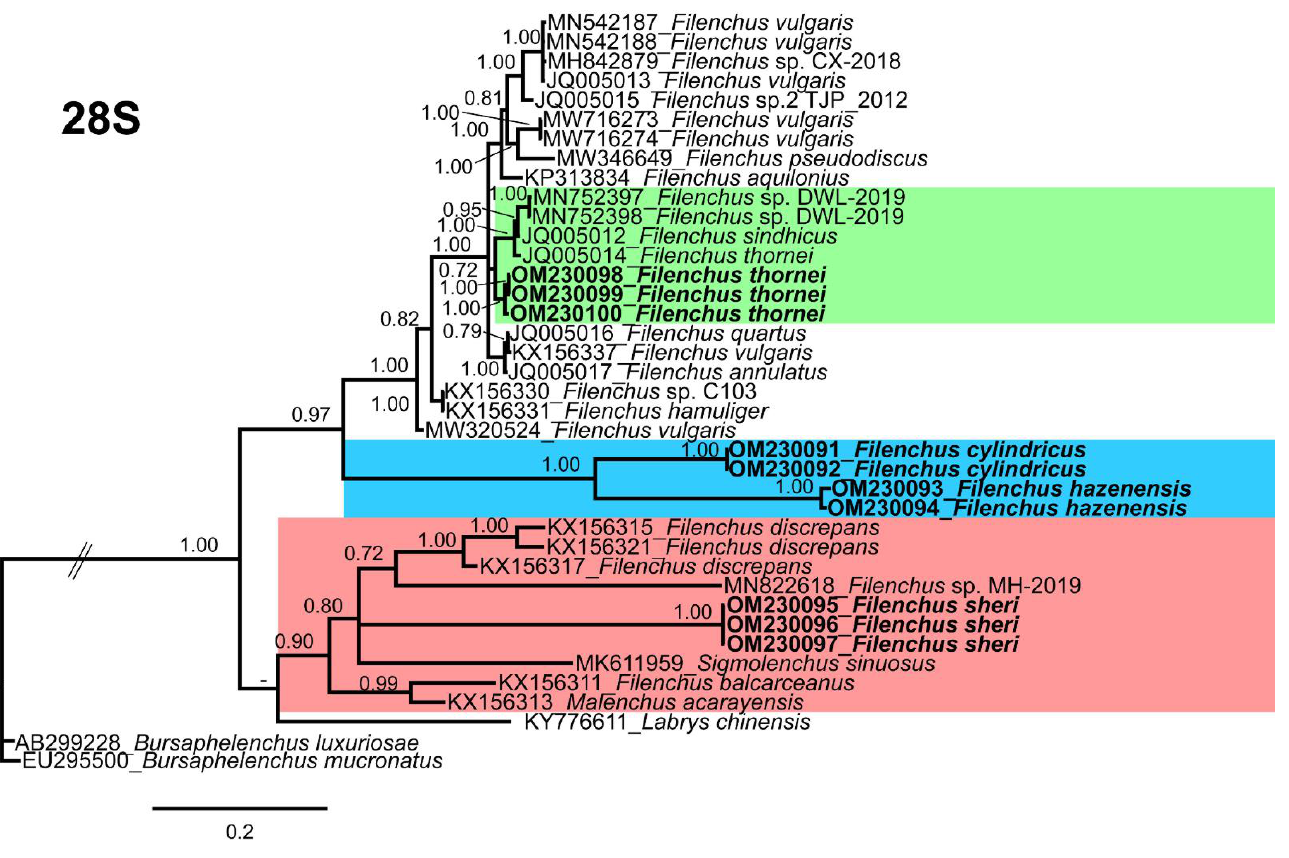
Figure 6. Phylogenetic relationships of the Canadian population of Filenchus species with related Tylenchidae species. Bayesian 50% majority rule consensus tree as inferred from D2 – D3 expansion domains of the 28S rRNA sequence alignment under the Tamura and Nei model with invariable sites and a gamma-shaped distribution (TrN + I + G). Posterior probabilities of greater than 0.70 are given for appropriate clades. The sequences produced in this study are shown in bold, and the colored boxes indicate the clade association of the recovered Filenchus species.